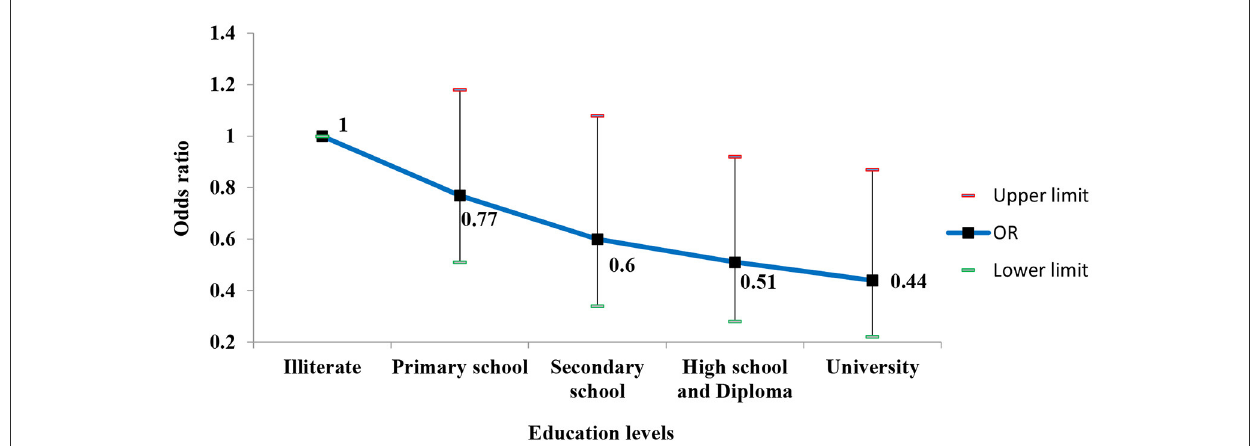
FIGURE1 Adjusted odds ratios (95% CI) of hearing loss according to levels of education.